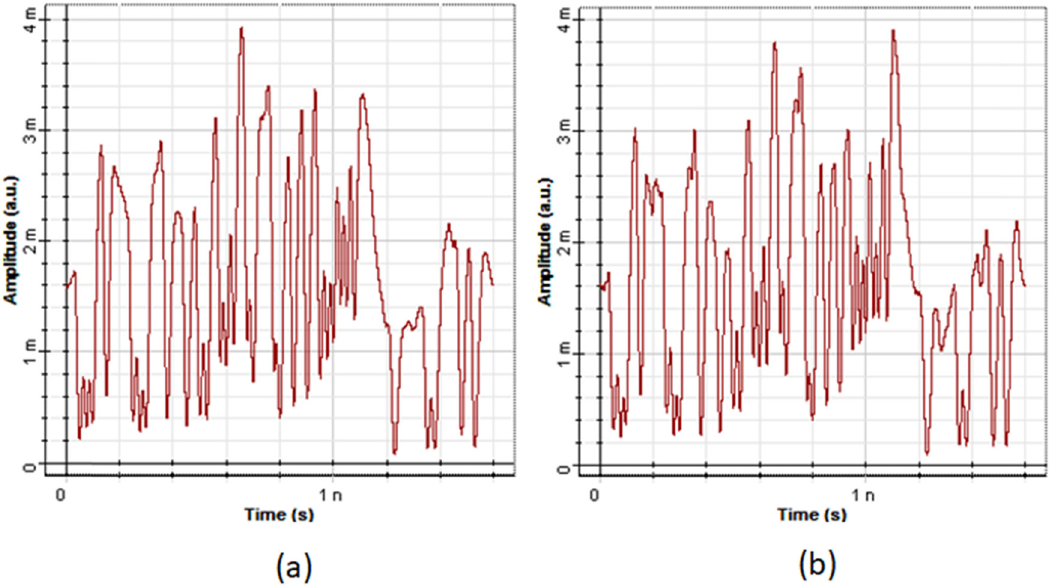
Figure 10: Amplitude vs time directly after Photodetector ( PIN ) at the side receiver for output: ( a ) signal_1 = 193.1 THz and ( b ) signal_4 = 193.4 THz @span = 200 km, and bitrate = 40